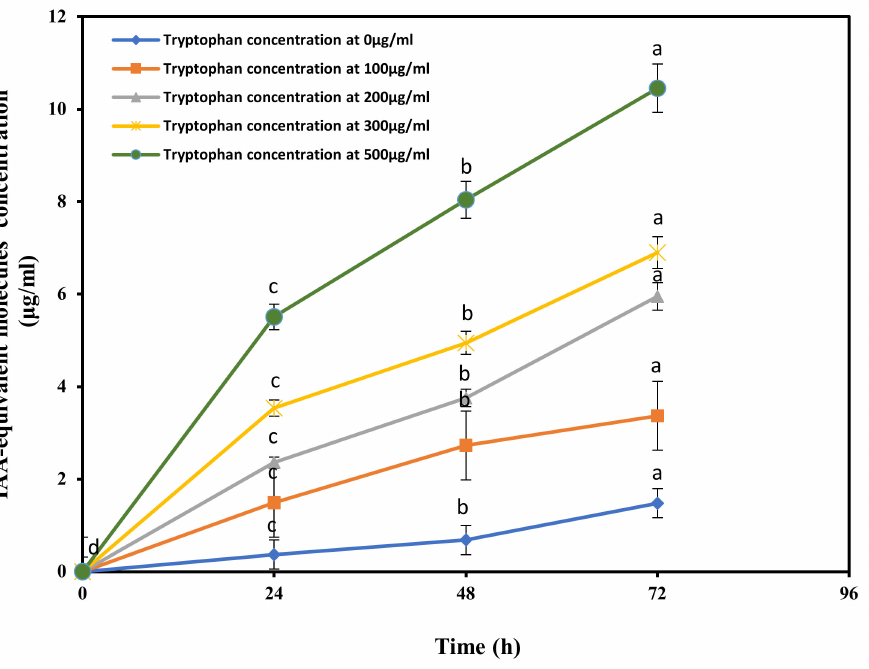
Figure 2. Production of indole acetic acid (IAA) by R. aquatilis JZ-GX1 in the presence of L-tryptophan at various concentrations. Vertical SD bars were added above the line charts, and the different letter above the SD bars indicates very significant difference according to Tukey’s HSD at p ≤